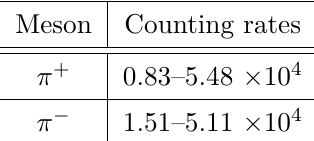
Table 5 . Estimated counting rates at JLab for π ± γ photoproduction with a kinematical cut of ( − t 0 ) > 1 . 7 GeV 2